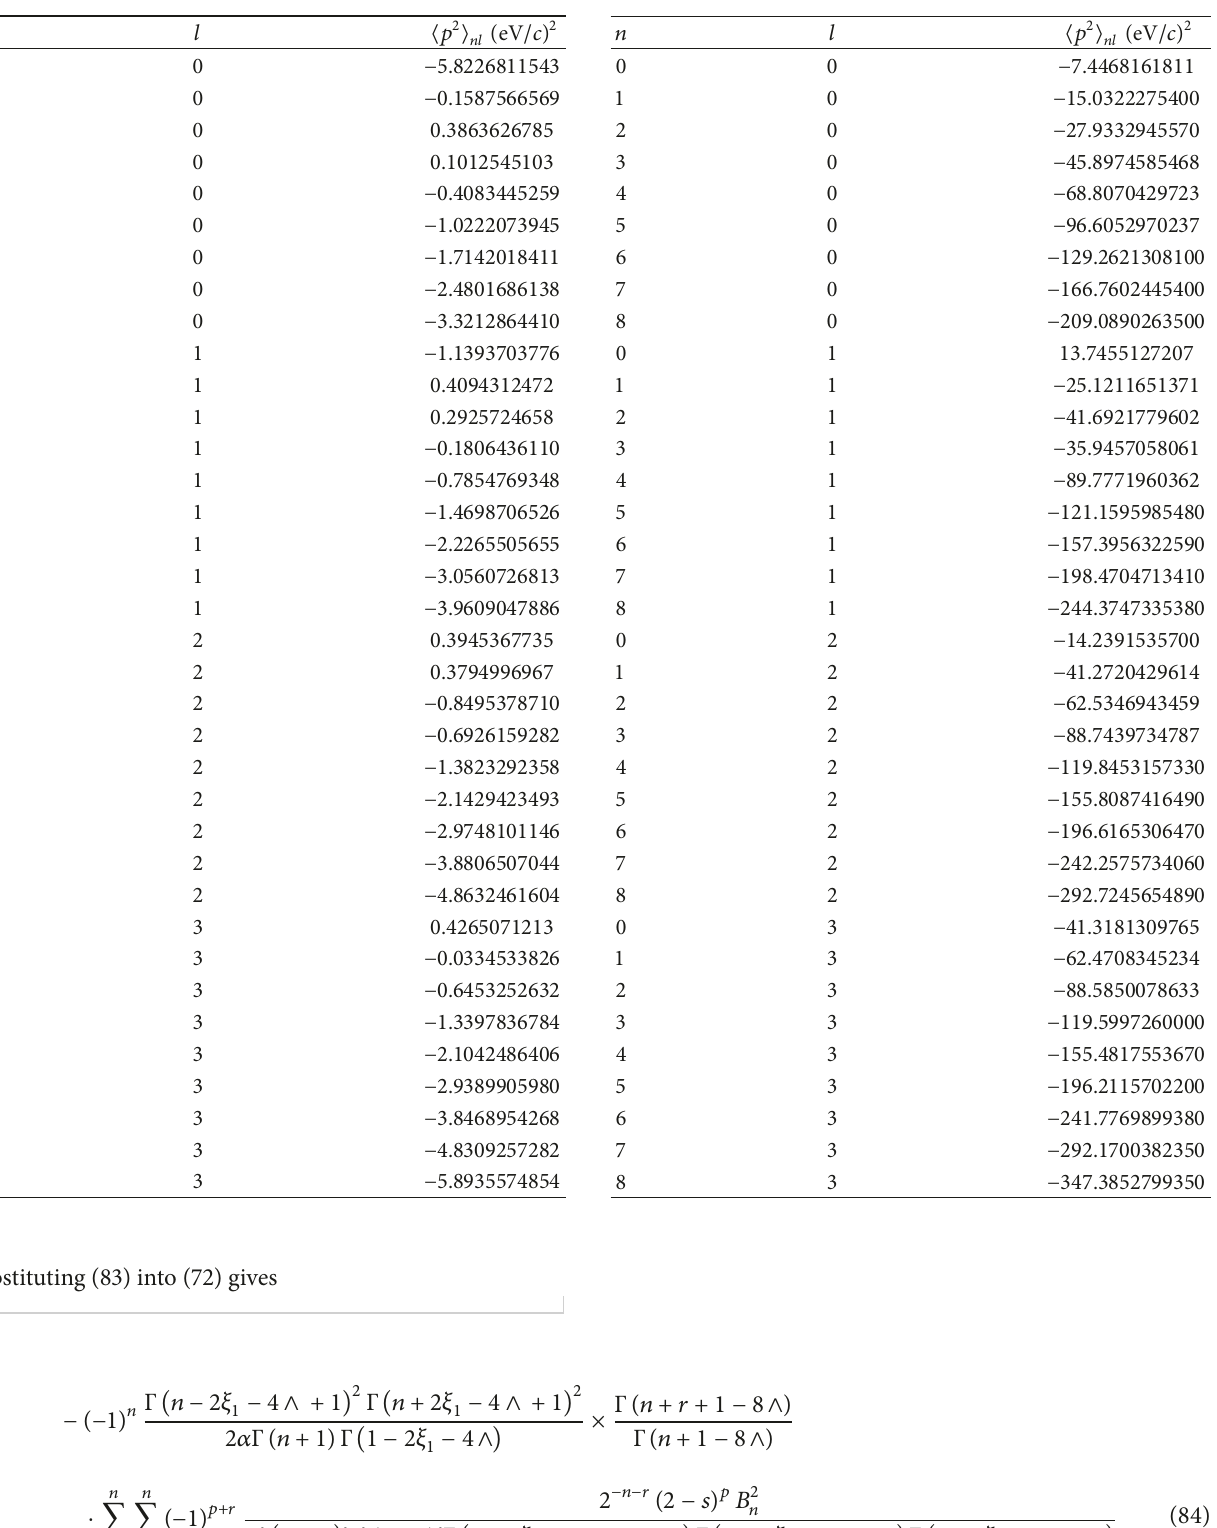
Table 14: Expectation values of ⟨𝑃 2 ⟩ for hydrogen molecule. Table 15: Expectation values of ⟨𝑝 2 ⟩ for lithium hydride